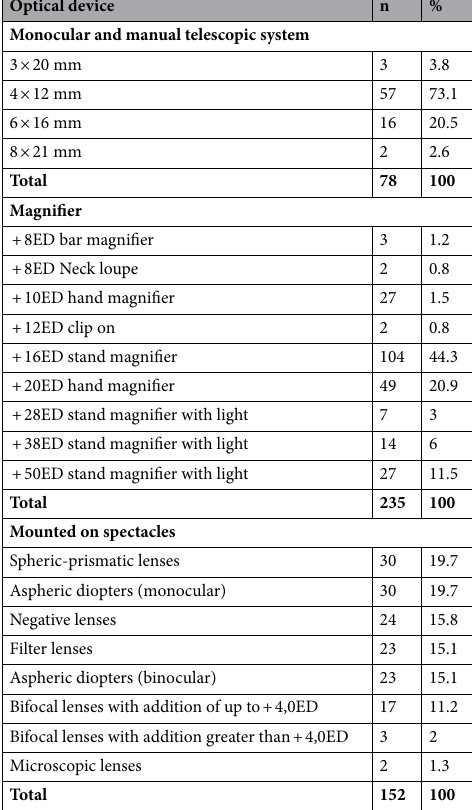
Table 5. Type and number of donated optical devices and spectacles. ED spherical